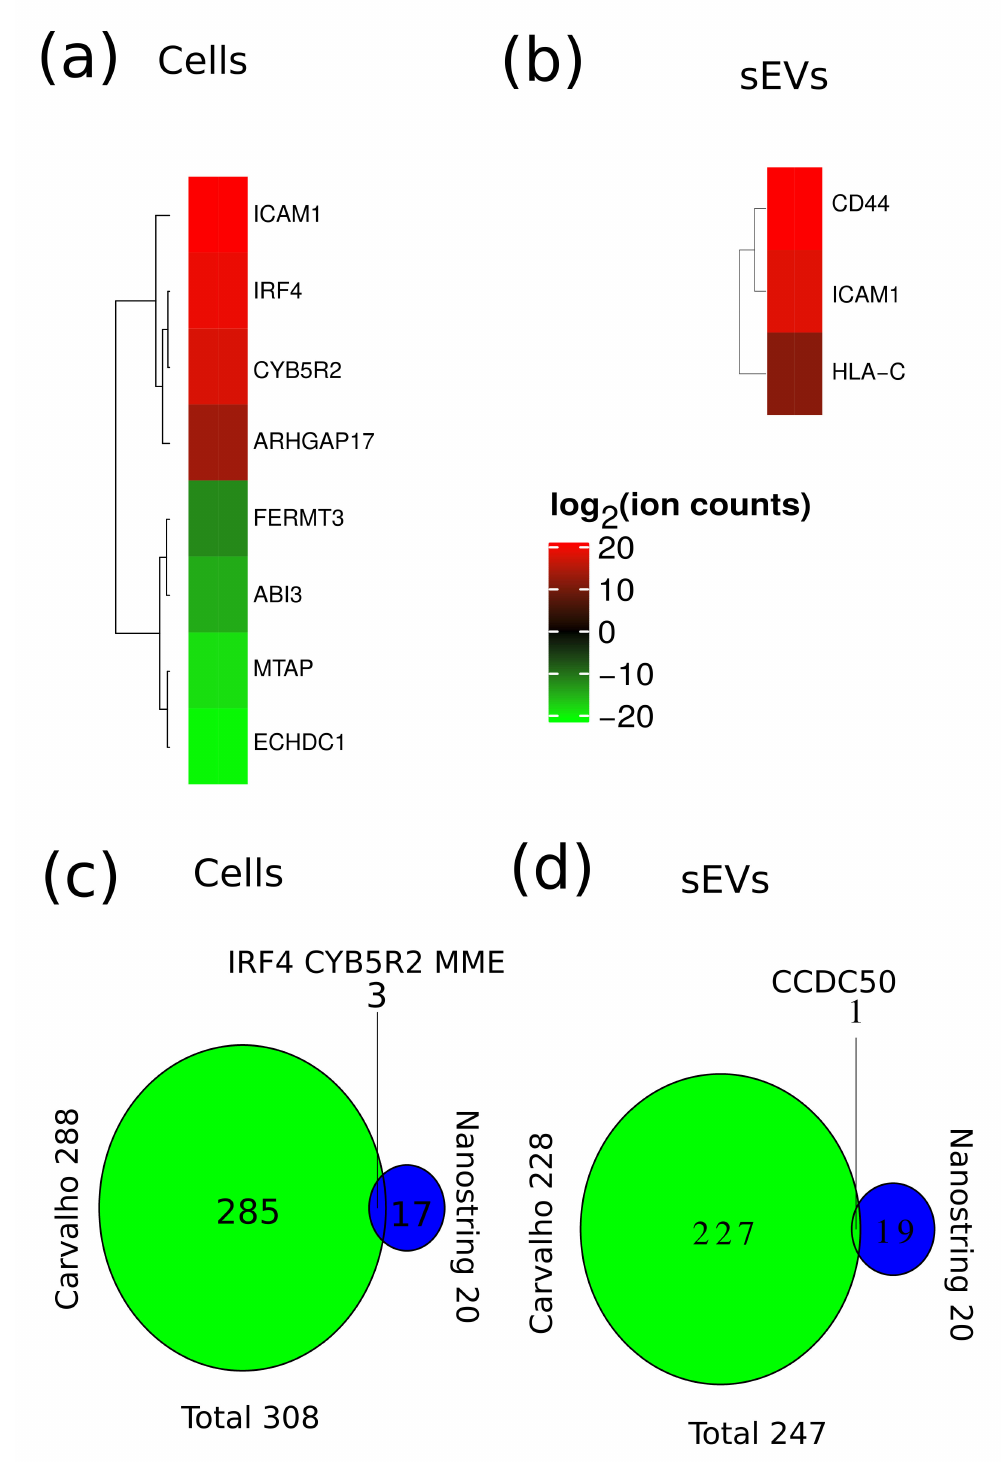
Figure A5. Overlap of potential markers with previous proposed markers. ( a ) Overlap and regulation of potential markers from Mann et al. whole proteome data with Carvalho et al. cell ( a ) and EVs ( b ). Overlap of markers from Nanostring technology with Carvalho et al. cell ( c ) and EVs ( d